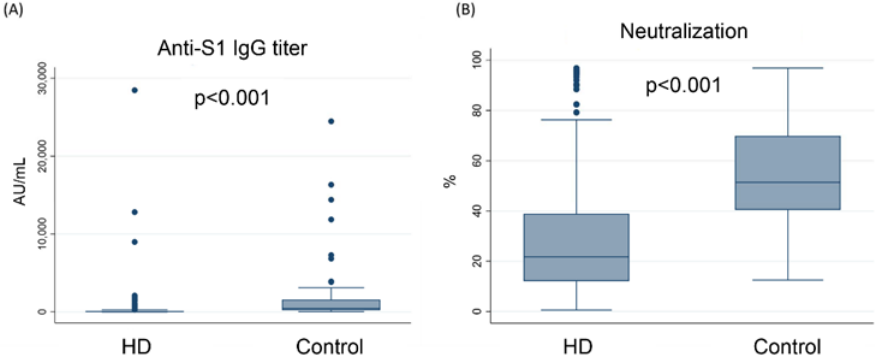
Figure 1. Anti-S1 IgG concentrations ( A ), and sVNT-measured neutralization ( B ), between control group and hemodialysis patients. Abbreviations: AU, arbitrary unit; HD, hemodialysis; S1, the S1 sub-unit of the spike protein; sVNT, surrogate virus neutralization test.